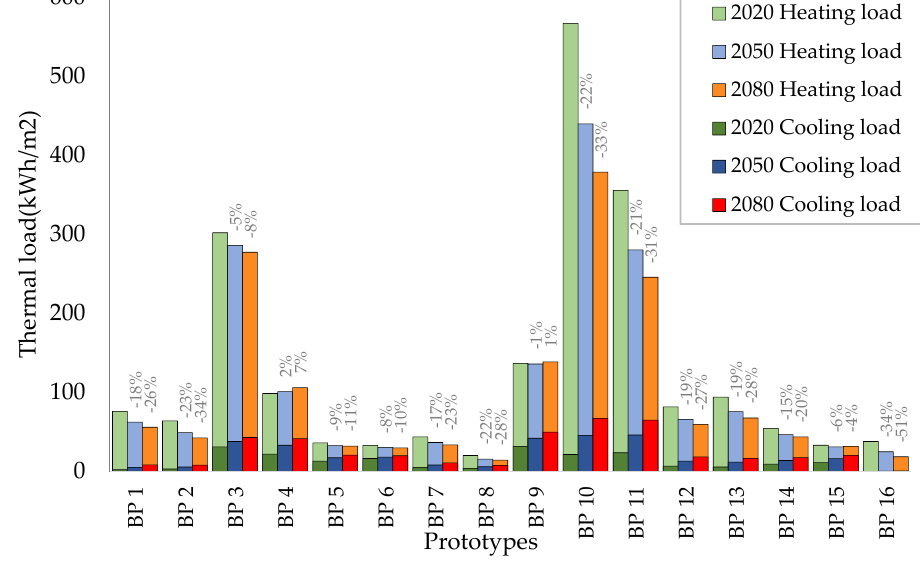
Figure 7. Change in the thermal load of building prototypes in 2020–2080 categorized by heating and cooling share; numbers demonstrate relative changes of values for 2050 and 2080 compared to 2020.